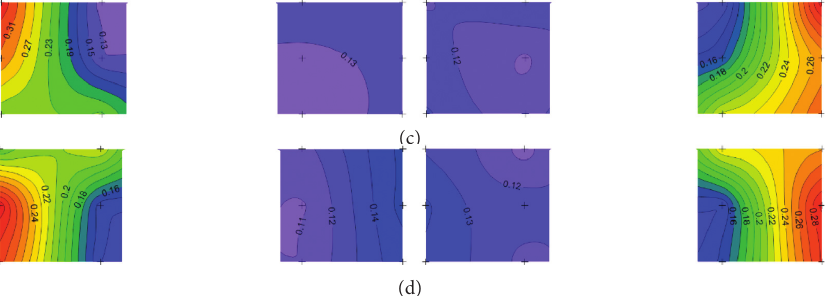
Figure 18: Fluctuating wind pressure coefficients of wall AB in the x -direction. (a) Wall AB at the upper opening in the model of L-3. (b) Wall AB at the lower opening in the model of L-3. (c) Wall AB at the upper opening in the model of L-2. (d) Wall AB at the lower opening in the model of L-2.